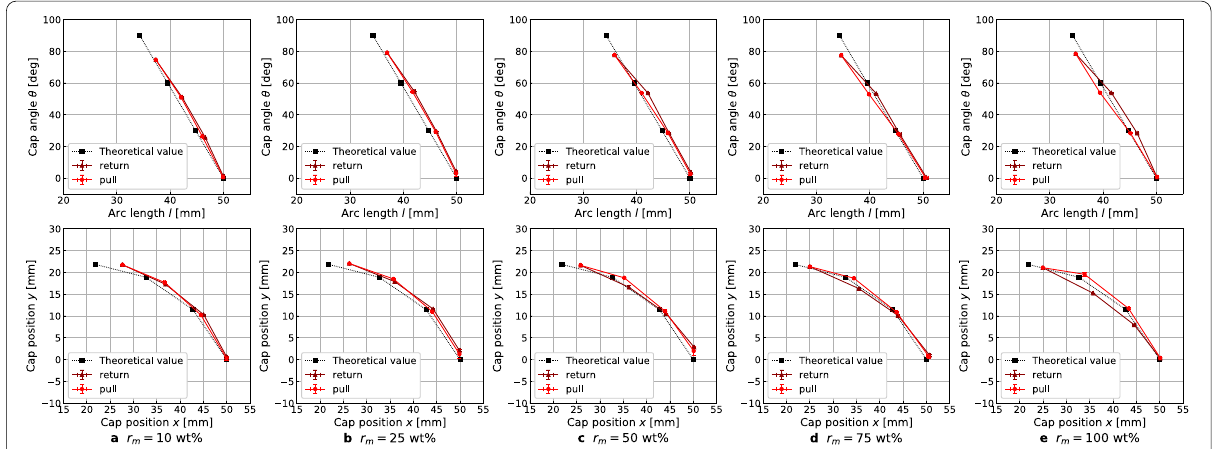
Fig. 8 Trajectories in configuration space c = [ l θ ] T (top) and task space p = [ x y ] T (bottom) of deformation pattern (a). Each plot represents the mean value of the three times. The error bars represent the standard deviation.